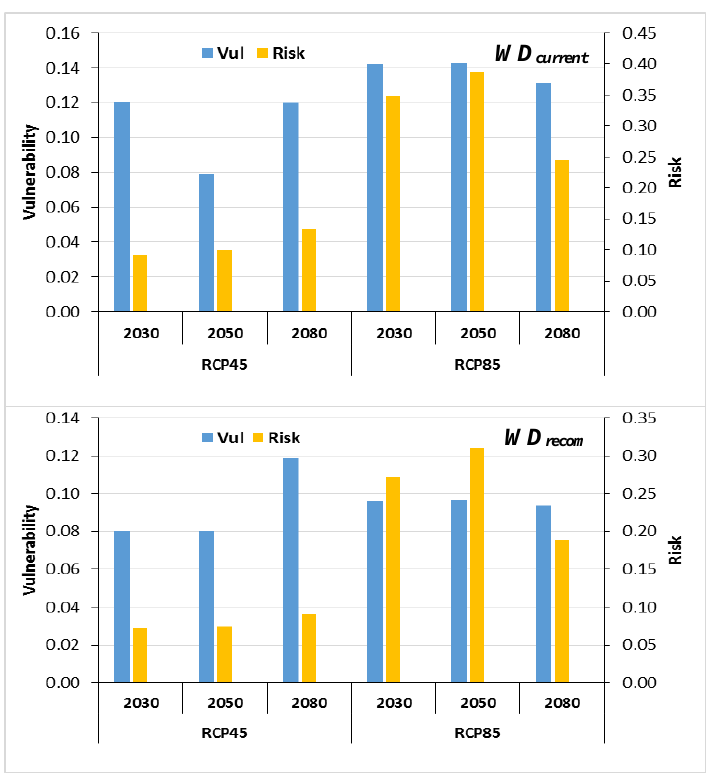
Figure 7. Weighted- average vulnerability and risk for the different RCP/periods for water demand scenario WD current ( top panel ) and WD recom ( bottom panel ).